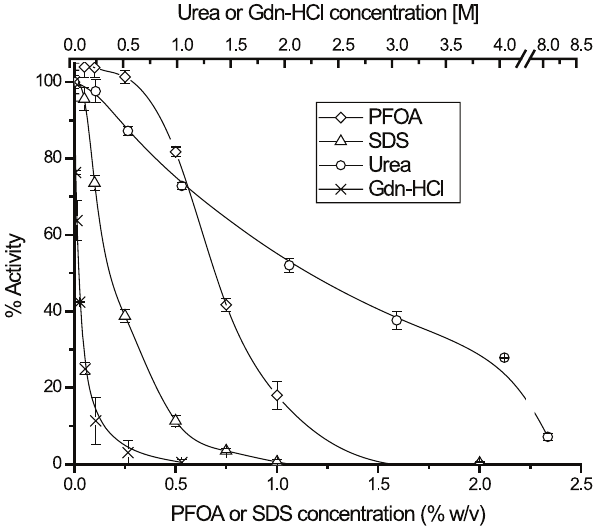
Figure 2. Different solubilizing agents affected the activity of trypsin. The amidase activity of trypsin was measured by monitoring the initial rate of the hydrolysis of Ac-Lys- p -nitroanilide. Each line in the graph represents the concentration dependent decrease in tryptic activity in the presence of various concentrations of PFOA ( e ), SDS ( D ), urea ( # ), and Gdn-HCl (x).